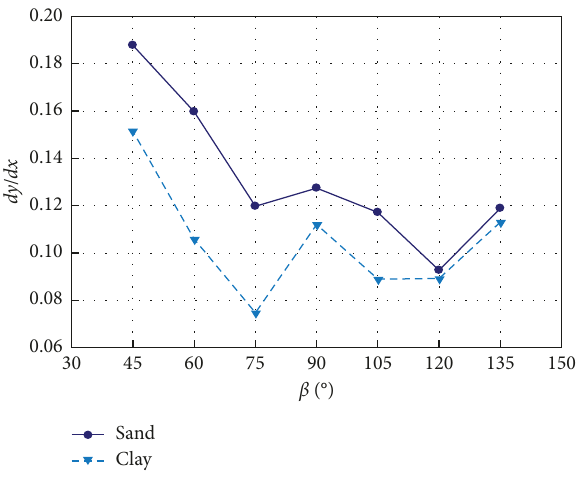
Figure 15: The relationship curves between the ground maximum absolute inclination angle and the fault dip angle. Figure 16: The relationship curves between d